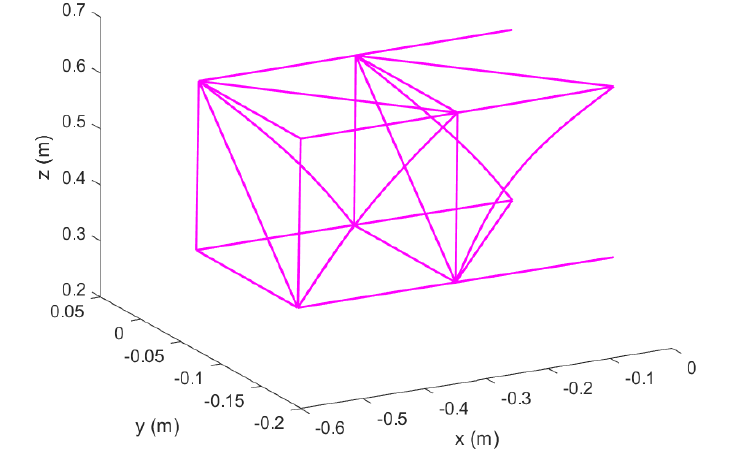
Figure 27. Mode 2 of Timoshenko beams in Topology 1 with hinged ends; original configuration.